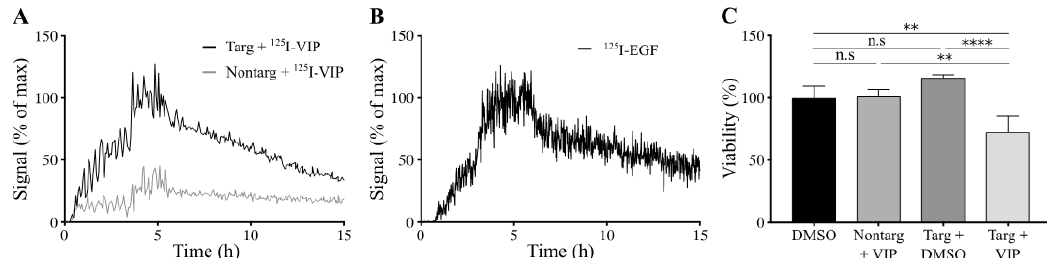
Figure 4. Characterization of lipodisks on HCT-EGFR cells. ( a ) Real-time binding of 125 I-VIP116 loaded on EGFR-targeted (black) and non-targeting (grey) lipodisks to HCT-EGFR cells. Binding was studied for three consecutive concentrations, followed by a dissociation phase. ( b ) Corresponding real-time binding measurements of 125 I-EGF on HCT-EGFR cells. ( c ) XTT viability assays on HCT-EGFR cells, demonstrating reduced cell viability in cells treated with EGFR-targeted lipodisks carrying VIP116, whereas no effects were observed from neither non-targeted lipodisks carrying VIP116, nor from EGFR-targeted lipodisks carrying no VIP116 (mean values, SD. N = 3). Nontarg = non-targeting lipodisks. Targ = targeting lipodisks. VIP =VIP116. ** p < 0.01, **** p < 0.001.